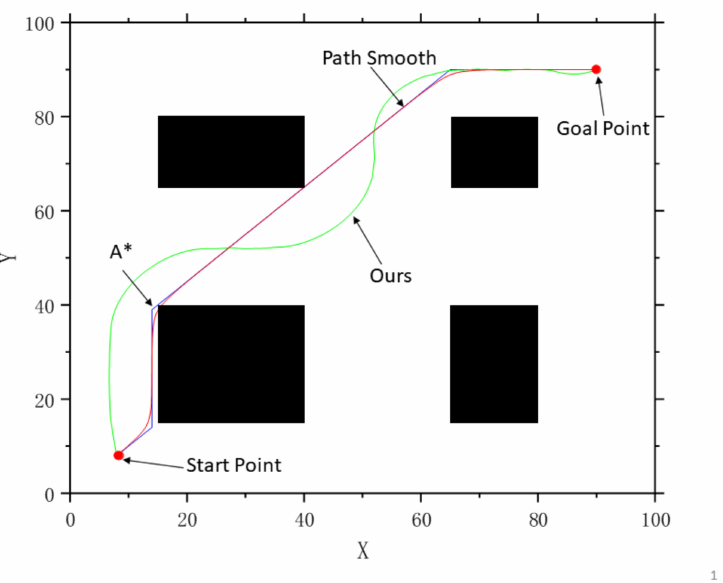
Figure 8. The paths generated by our proposed path-generation algorithm (green), the Path Smooth algorithm (red), and the A* algorithm (blue) in the first experiment.